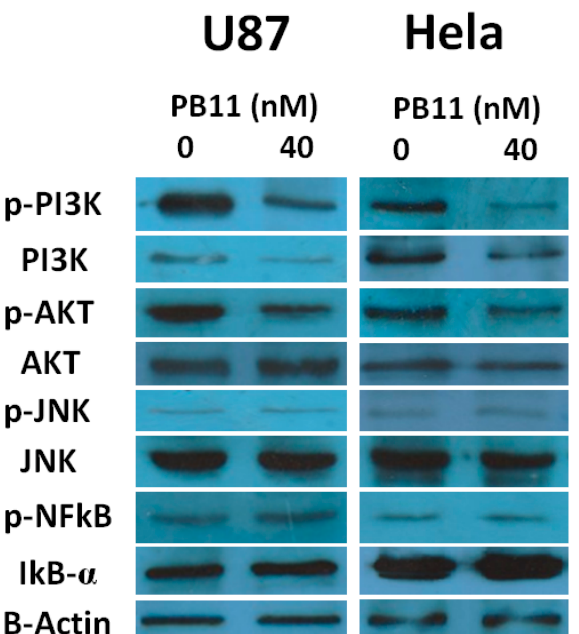
Figure 5. Suppression of the PI3K/AKT pathway by PB11. U87 and HeLa cells were grown in 6-well culture plates with or without 40 nM PB11. After 48 h, cell lysates were prepared and blotted with antibodies against PI3K, p-PI3K, JNK, p-JNK, I κ B α , NF κ B p65, AKT, and p-AKT. B-actin was used as a loading control.